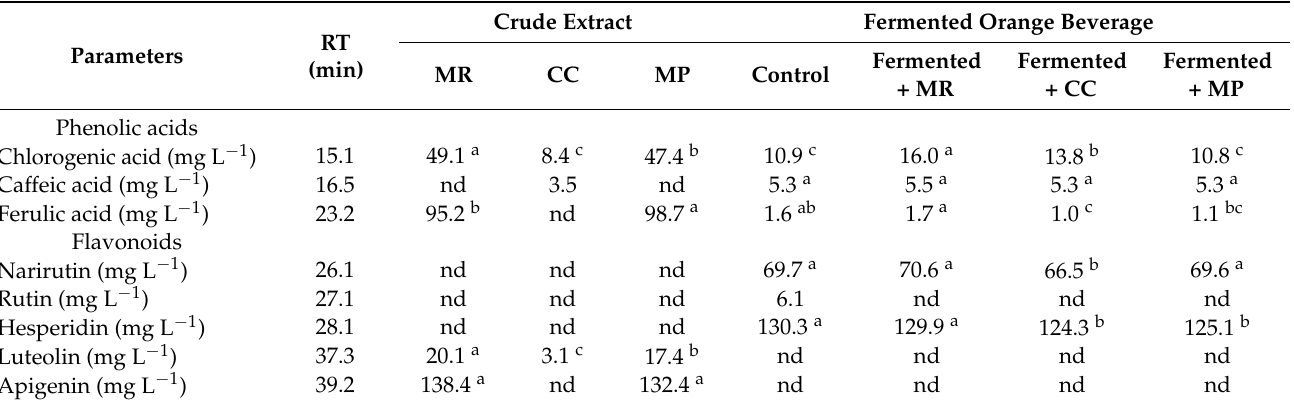
Table 3. Phenolic composition of the functional fermented orange beverage containing aromatic herbal